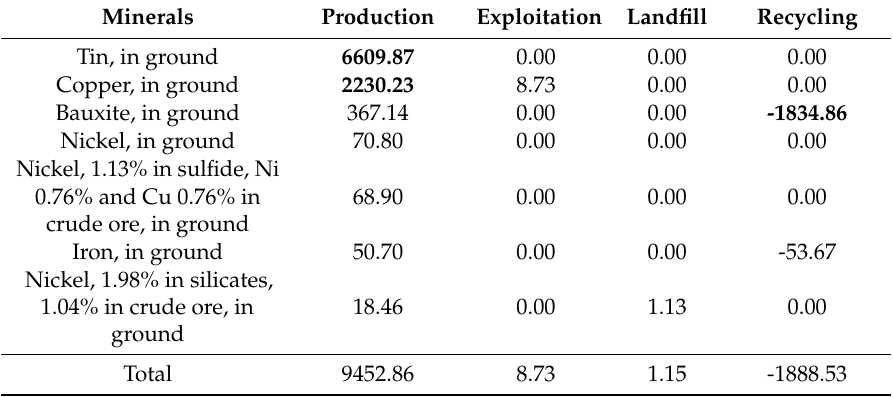
Table 13. Results of grouping and weighting of after-e ff ects of environmental processes related to mineral extraction, occurring in the 1 megawatt photovoltaic power plant [unit: Pt].